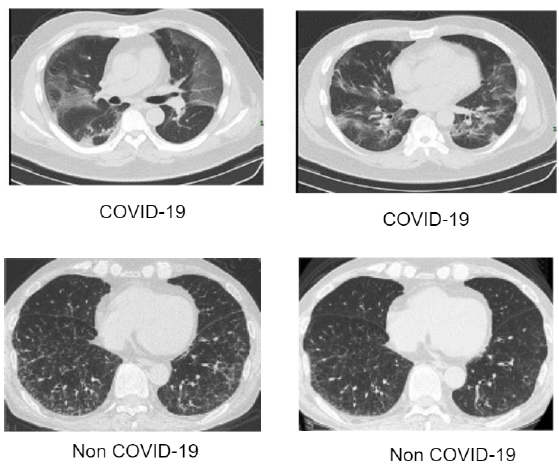
Figure 2. Data collection of computed tomography (CT) images of COVID-19 and